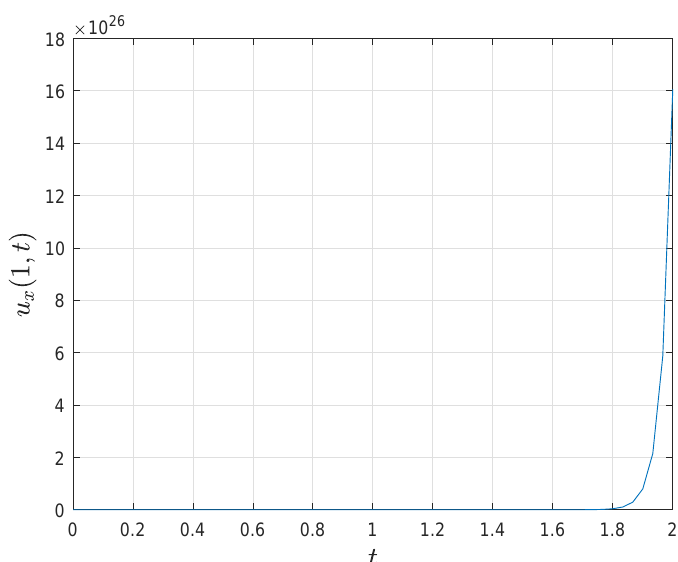
Figure 3. Open-loop behavior at the right hand side boundary from the R-A-D PDE.